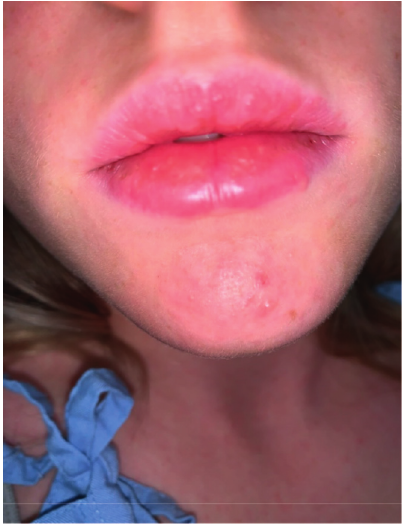
Figure 4: Superficial lip